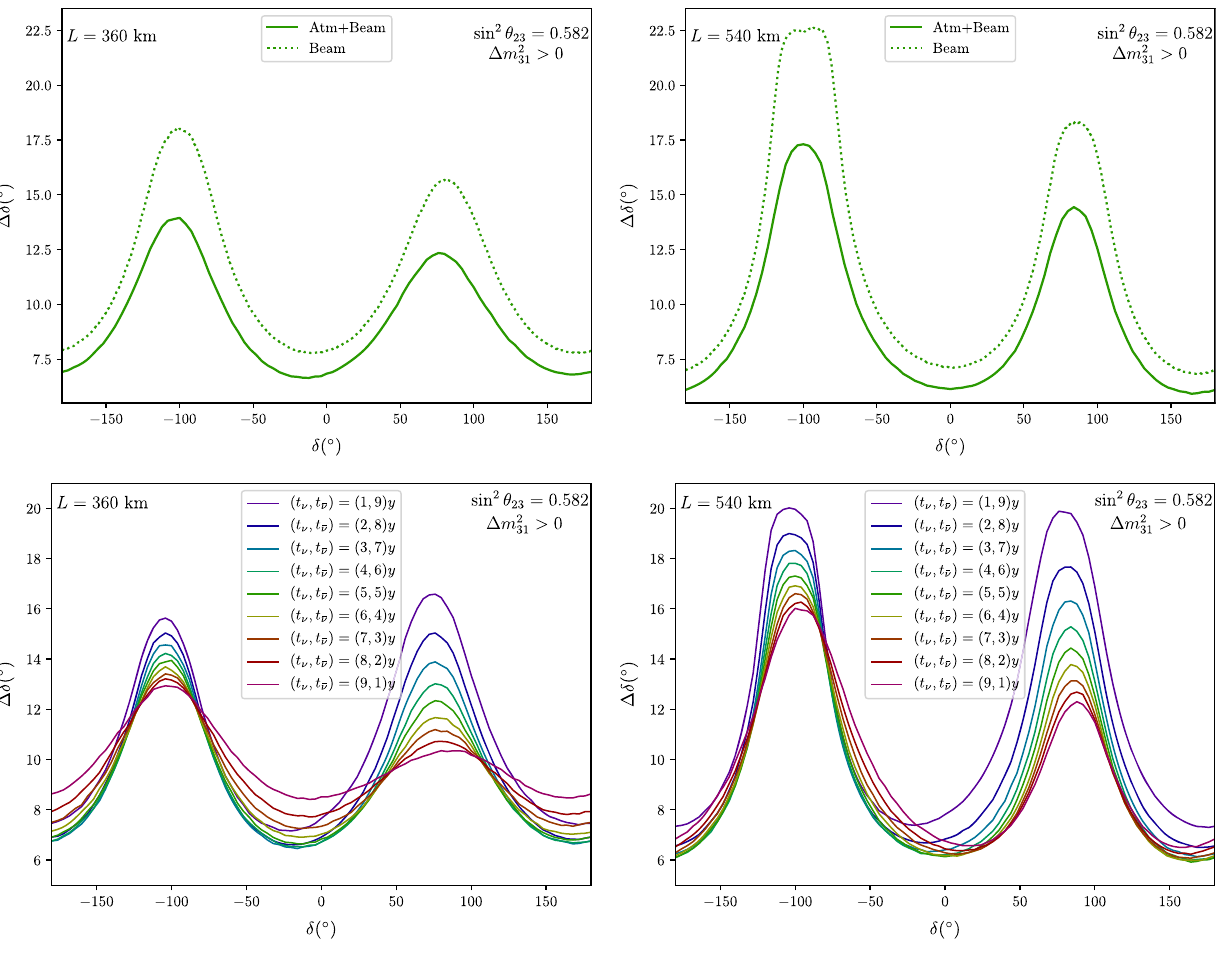
Fig. 8 Precision (spread of the 1 σ allowed region) on the determi- nation of δ for the baseline to Zinkgruvan L = 360 km (left panels) and Garpenberg L = 540 km (right panels) for the current best-fit parameters [24]. In the upper panels we show the comparison between the precision obtained with (solid lines) and without (dashed lines) the